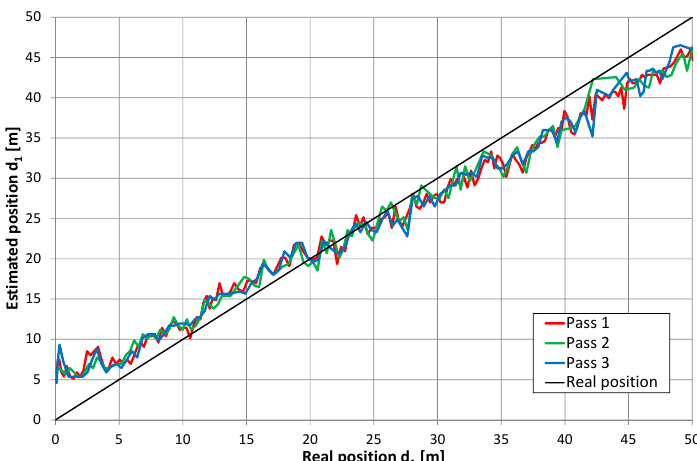
Figure 16. Results of position estimation in three measurement repetitions in series 12; the height of receiving antenna: 1 m.